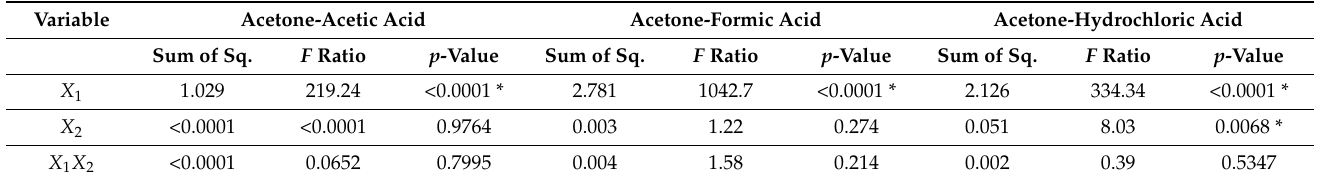
Table 1. The effects tests of the predicted quadratic polynomial models for the investigated response—total procyanidins ( α = 0.05).